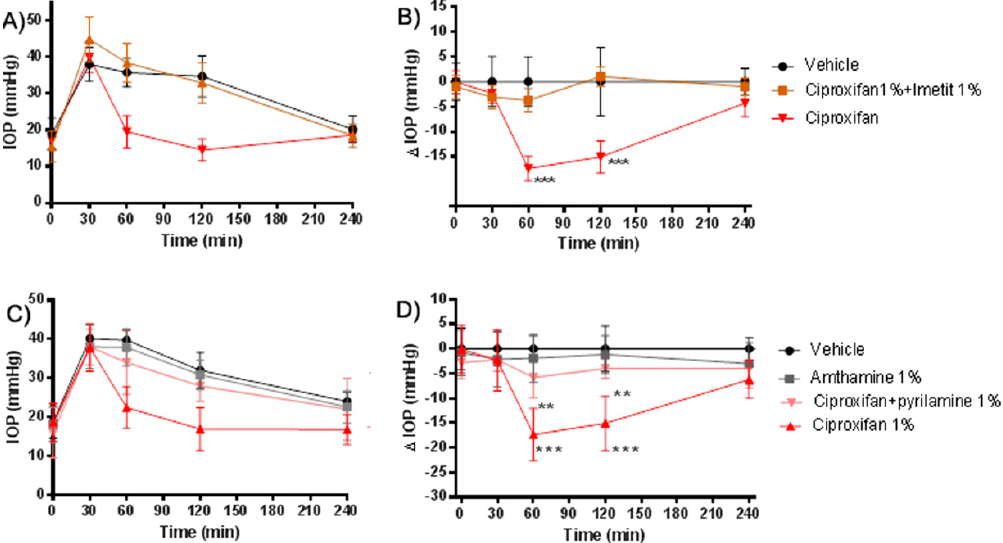
Figure 3. ( A , B ) Ciproxifan-Imetit intraocular pressure (IOP) time course. *** p < 0.001 ciproxifan 1% versus vehicle and versus ciproxifan + imetit 1% at 60 ′ and 120 ′ ; ( C , D ) amthamine and pyrilamine IOP time course. *** p < 0.001 ciproxifan 1% at 60 ′ and 120 ′ versus amthamine and vehicle; ** p < 0.01 ciproxifan versus ciproxifan + pyrilamine. Data are expressed as mean ± SEM ( n = 5). Two-way